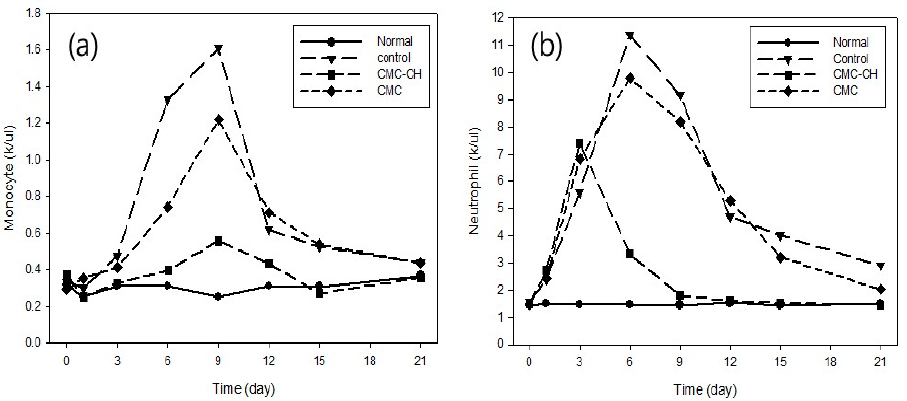
Figure 9. ( a ) Monocyte and ( b ) neutrophil in wound healing; Normal (harmless mice) control (non-treated wound), CH–CM (CH–CMC hydrogels treated wound), CMC (CMC hydrogels treated wound).